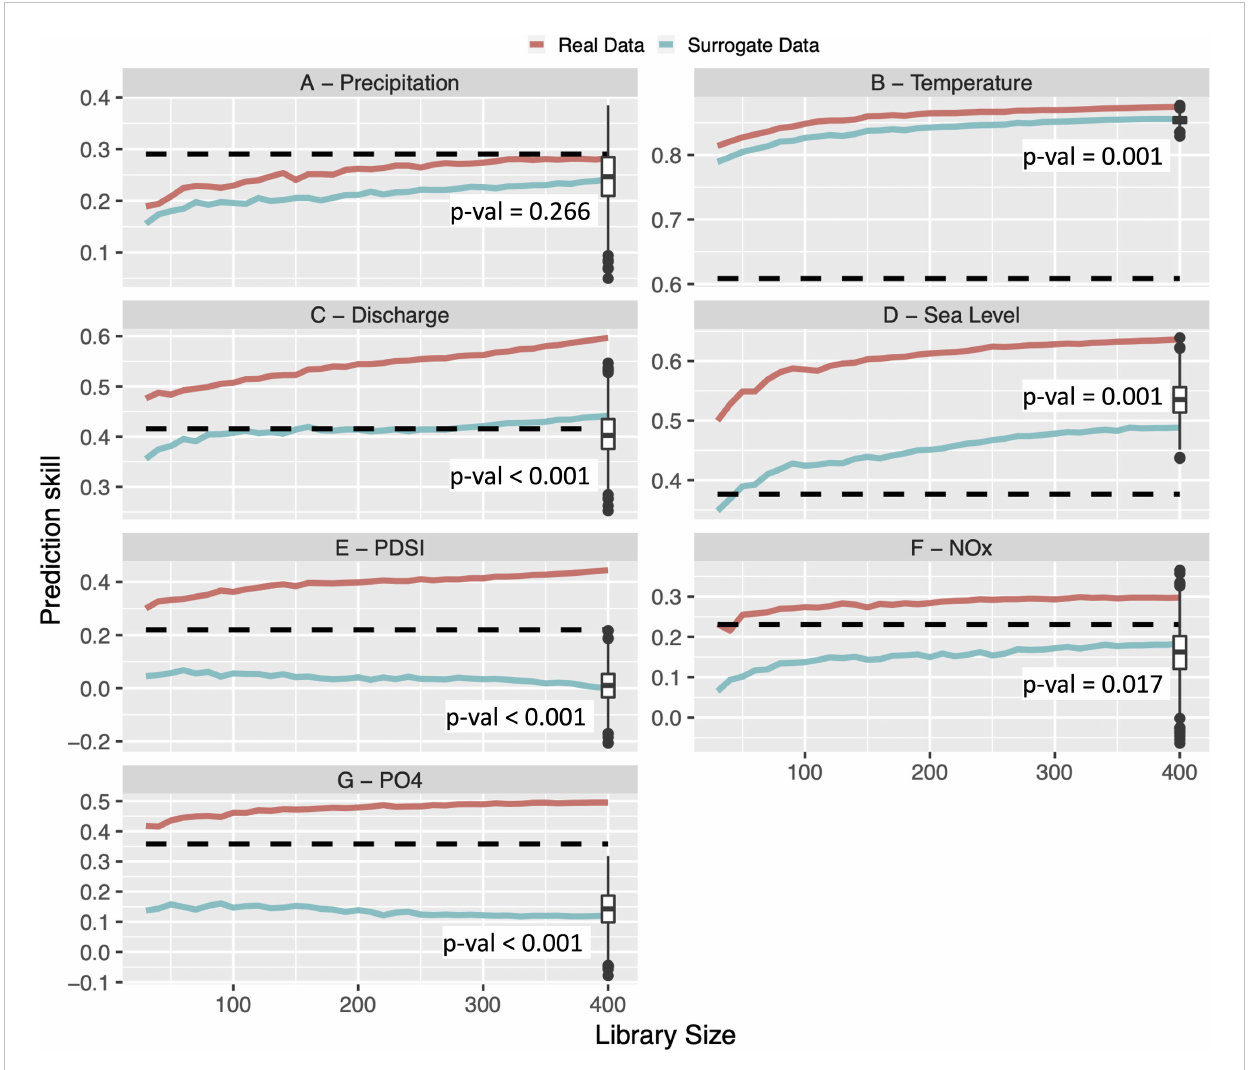
FIGURE 6 Convergent cross mapping results: real (red) and one instance of surrogate (blue) for each environmental variable (precipitation (A) , temperature (B) , discharge (C) , sea level (D) , PDSI (E) , NO x (F) and PO 43 – (G) ) vs biomass. Horizontal dashed black lines show the maximum cross correlation between the (time-shifted) environmental variable and biomass. Library size represents the length of the time series used in CCM. The prediction skill measures the strength of the connection between environmental variables and biomass. Zero or negative prediction skill indicates the lack of information about the dynamics of the environmental variable embedded in biomass (Sun et al., 2021). Boxes and whiskers show the range of prediction skill for surrogate data, interquartile range, median and outliers (signi fi cance tests comparing surrogate and observed data were run with full library